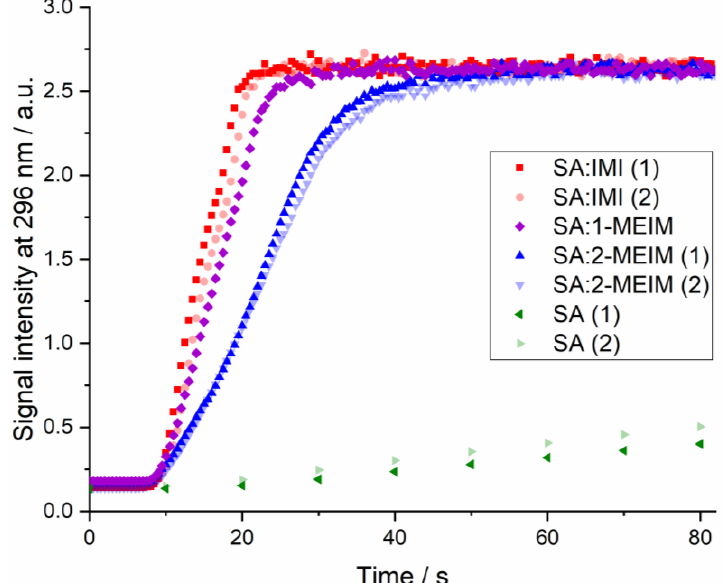
Figure 8. Dissolution rate plot of SA, SA:IMI, SA:1-MEIM and SA:2-MEIM, in both first (1) and second(2) assays, with intensity values of signal at 296 nm (SA absorption band) over relative time (addition of materials at 0 s).